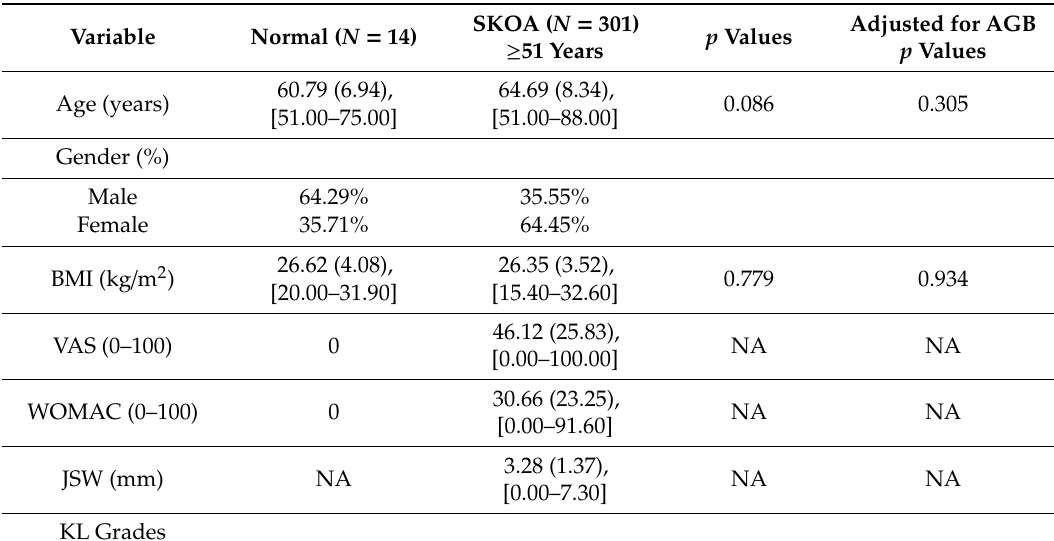
Table 2. Baseline demographics and biomarker levels of normal controls and SKOA patients of ≥ 51 years of